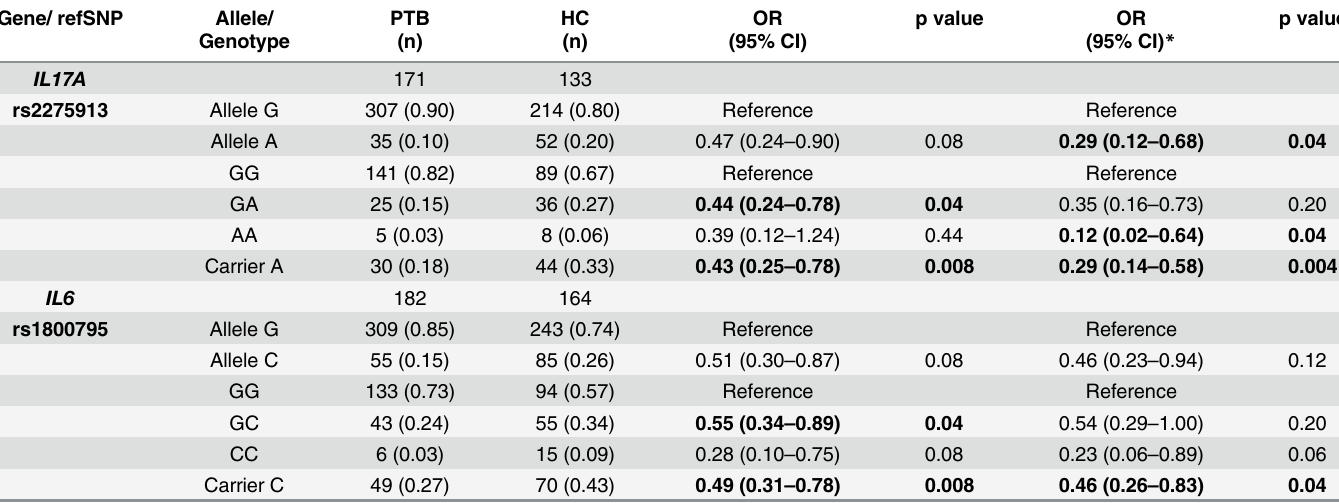
Table 2. Distribution of IL17A -197G > A and IL6 -174G > C Alleles, Genotypes and Carrier Frequencies in PTB Patients and Healthy Controls. Gene/